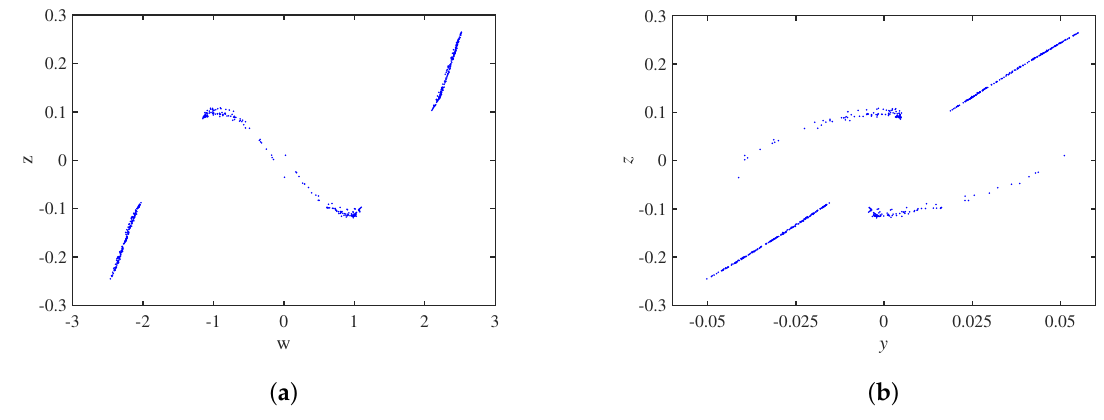
Figure 4. Poincaré maps: ( a ) y = 0; ( b ) x = 0.